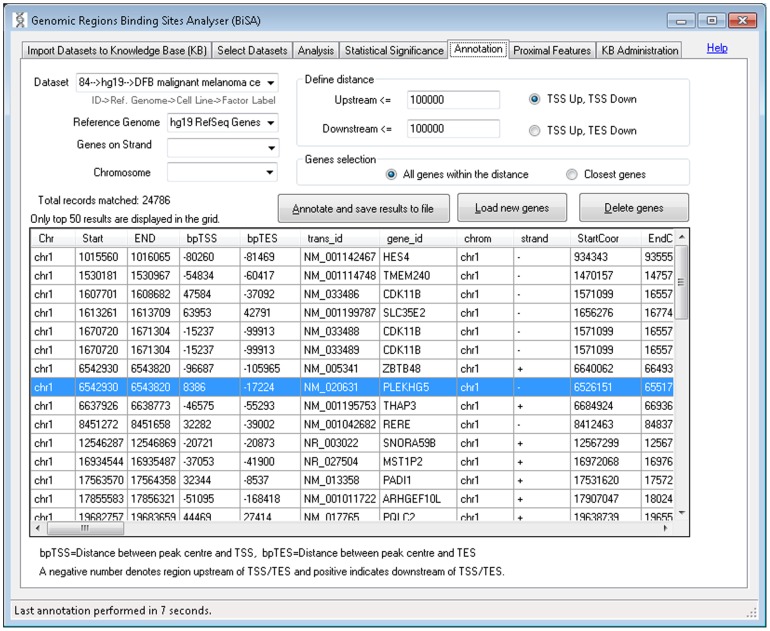
Gene annotation.The annotation tab allows the user to add gene information, from human and mouse reference genome assemblies, taken from the UCSC Genome Browser, to their data. This data can be saved in tab delimited text format for further analysis in other software. Annotation can be limited to a chromosome and strand. Start and End co-ordinate columns for transcript (tx) and cDNA (cds) represent the numerically lower and higher value chromosomal coordinates for genes on both strands. A negative value in the bpTSS or bpTES column indicates that the region is upstream of the annotated TSS or TES respectively. Therefore a region within a gene on the positive strand will have a negative bpTES value and a positive bpTSS value as for the region highlighted. Only the top 50 results are displayed in the grid, however, the full annotated dataset is saved in a tab delimited text file which can be opened in Excel or other spread sheet management software for further analysis. The delete genes button allows the user to delete custom uploaded definitions.